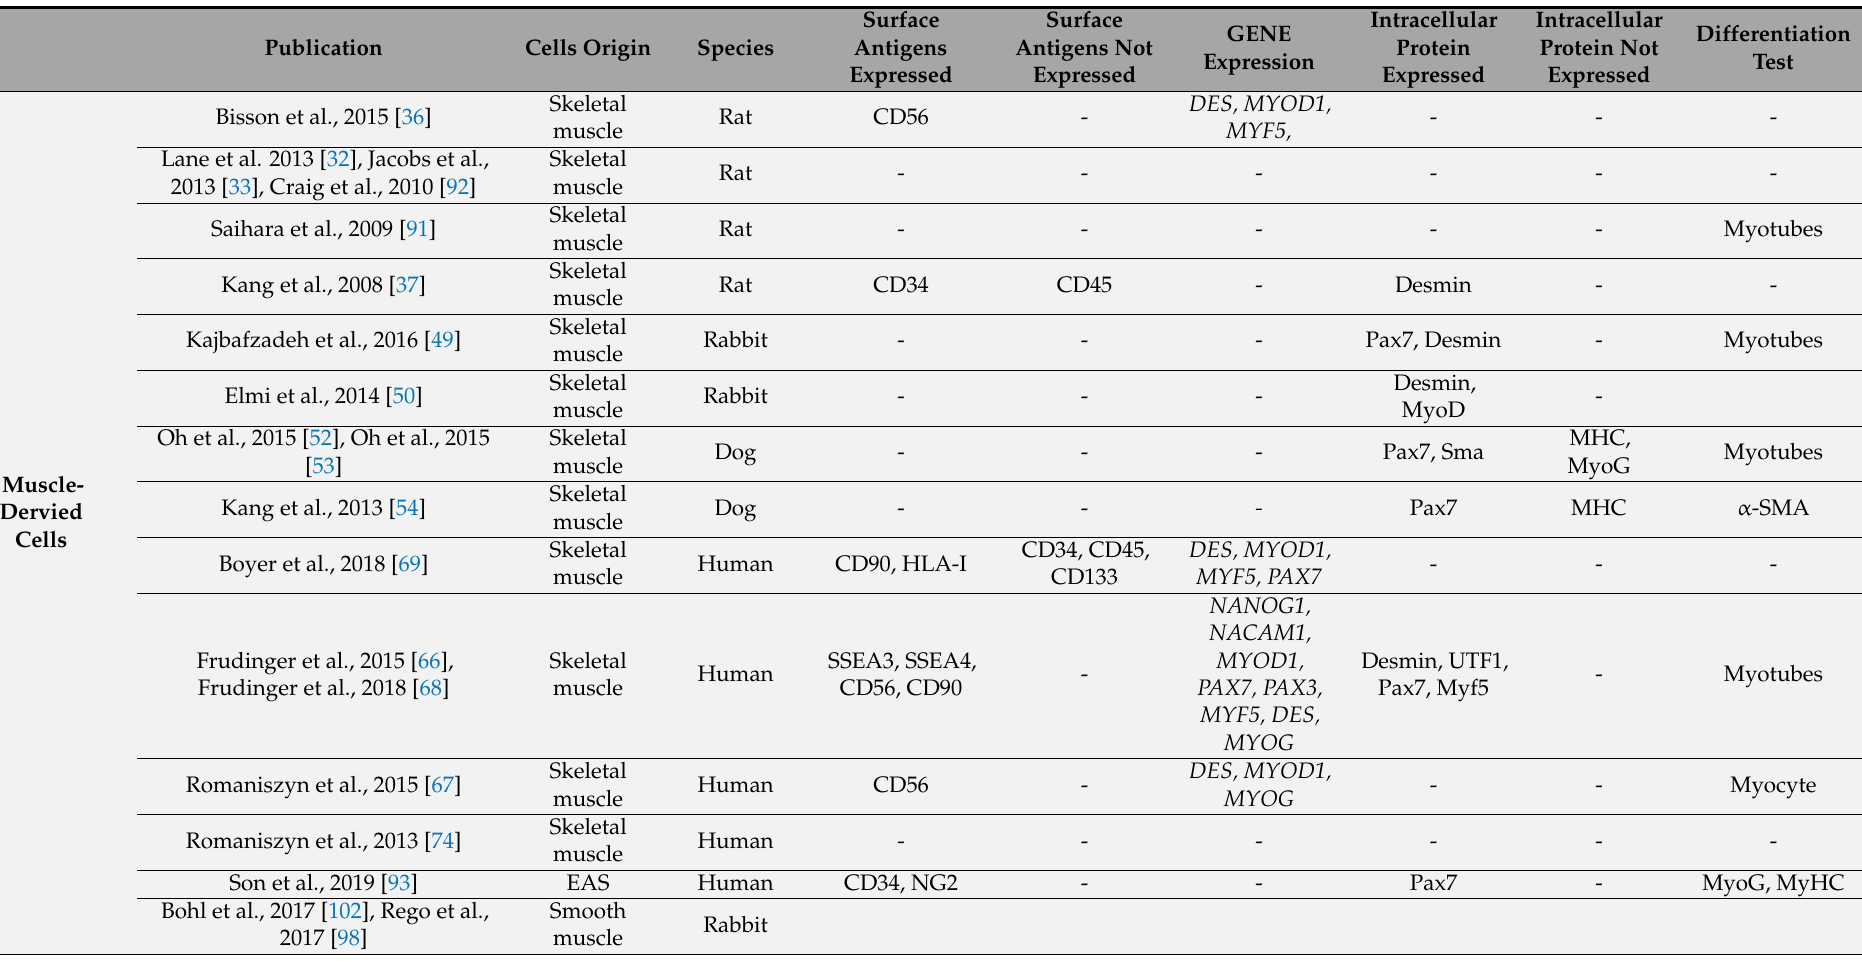
Table 3. Characteristics of primary cells proposed for cell therapy of anal sphincter incontinence. MHC: Myosin heavy chain, Sma: α -Smooth-muscle-actin, MyoG: